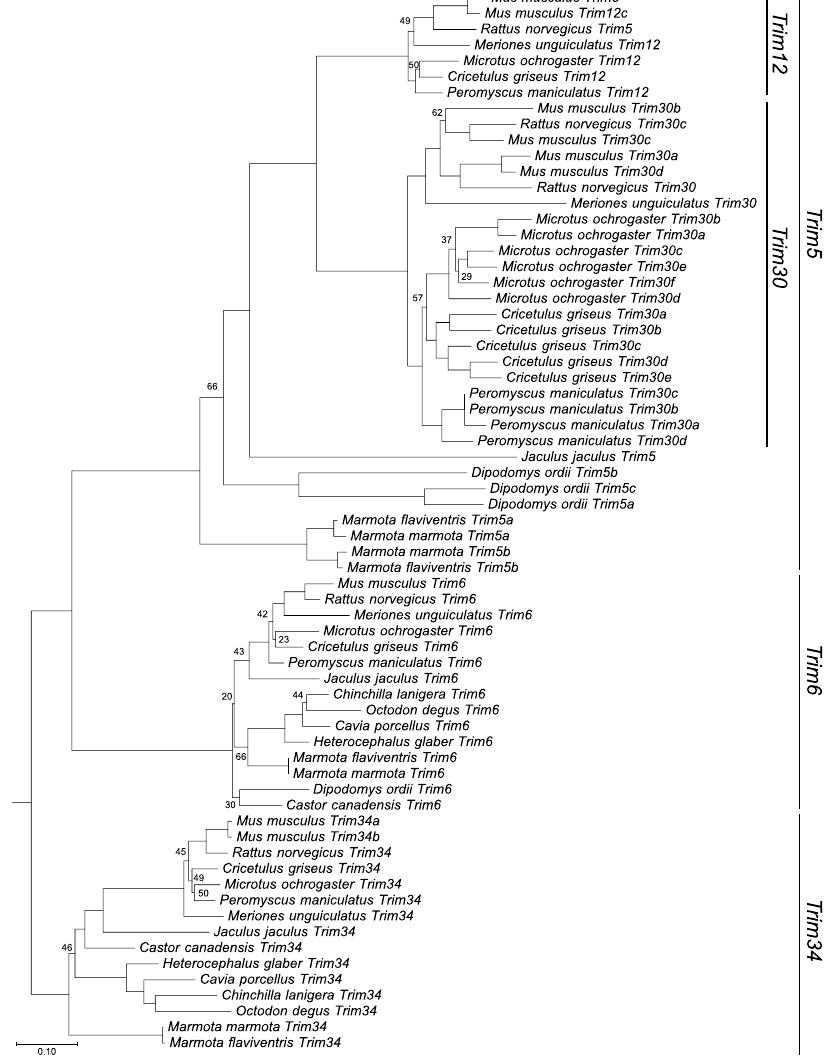
Figure 3. Phylogeny of the rodent Trim5 , Trim6 and Trim34 SPRY domains. ORFs coding for the SPRY domains of annotated Trim clade of genes in the Trim5 cluster of selected rodents were aligned and maximum likelihood trees were generated using RAxML with 500 replicates. Bootstrap values that are below 70 are shown at the relevant nodes. The tree was rooted with Human Trim22 . Phylogenetic grouping of each gene clade is indicated to the right of the